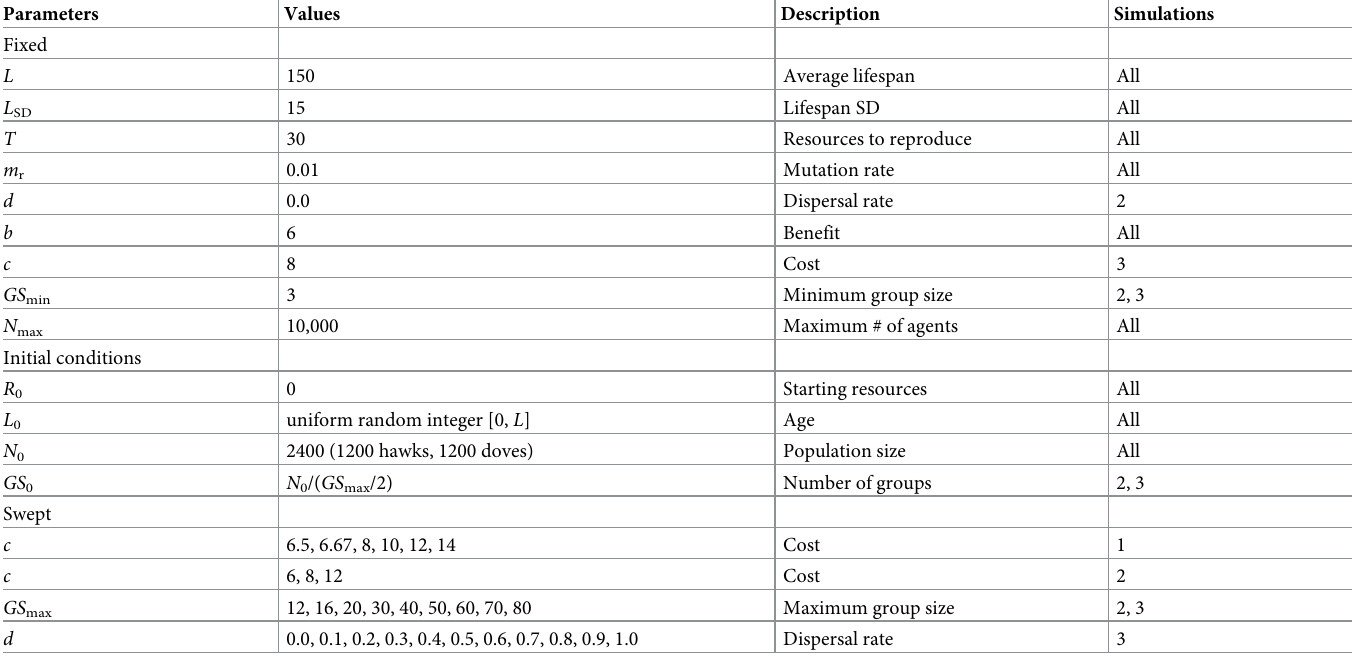
Table 1. Fixed parameters, initial conditions, and parameter